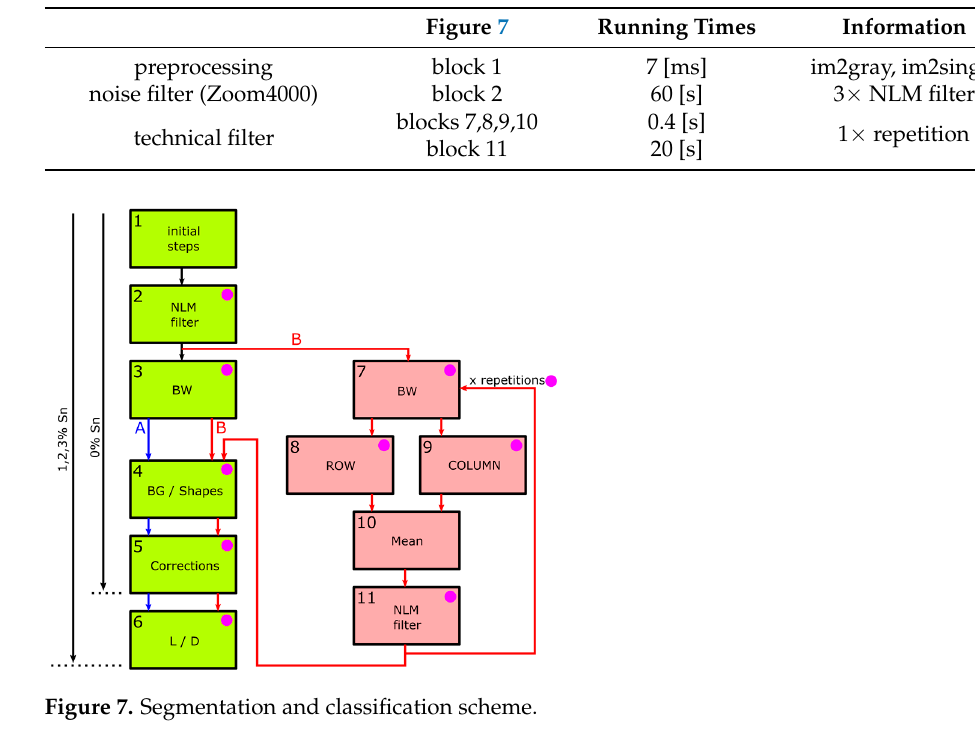
Table 6. Running times for the preprocessing, noise filter and technical filter.